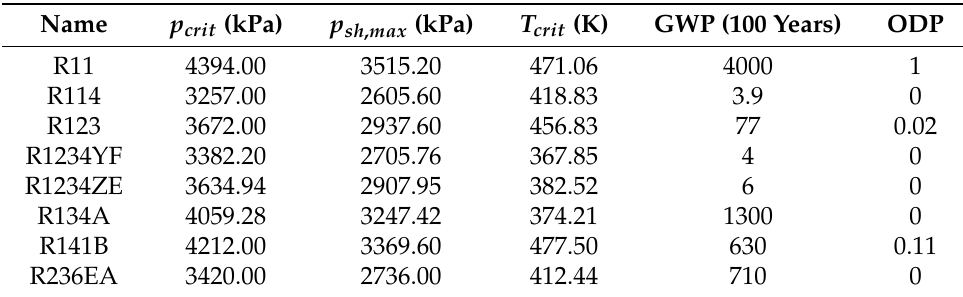
Table 2. Working fluids under analysis